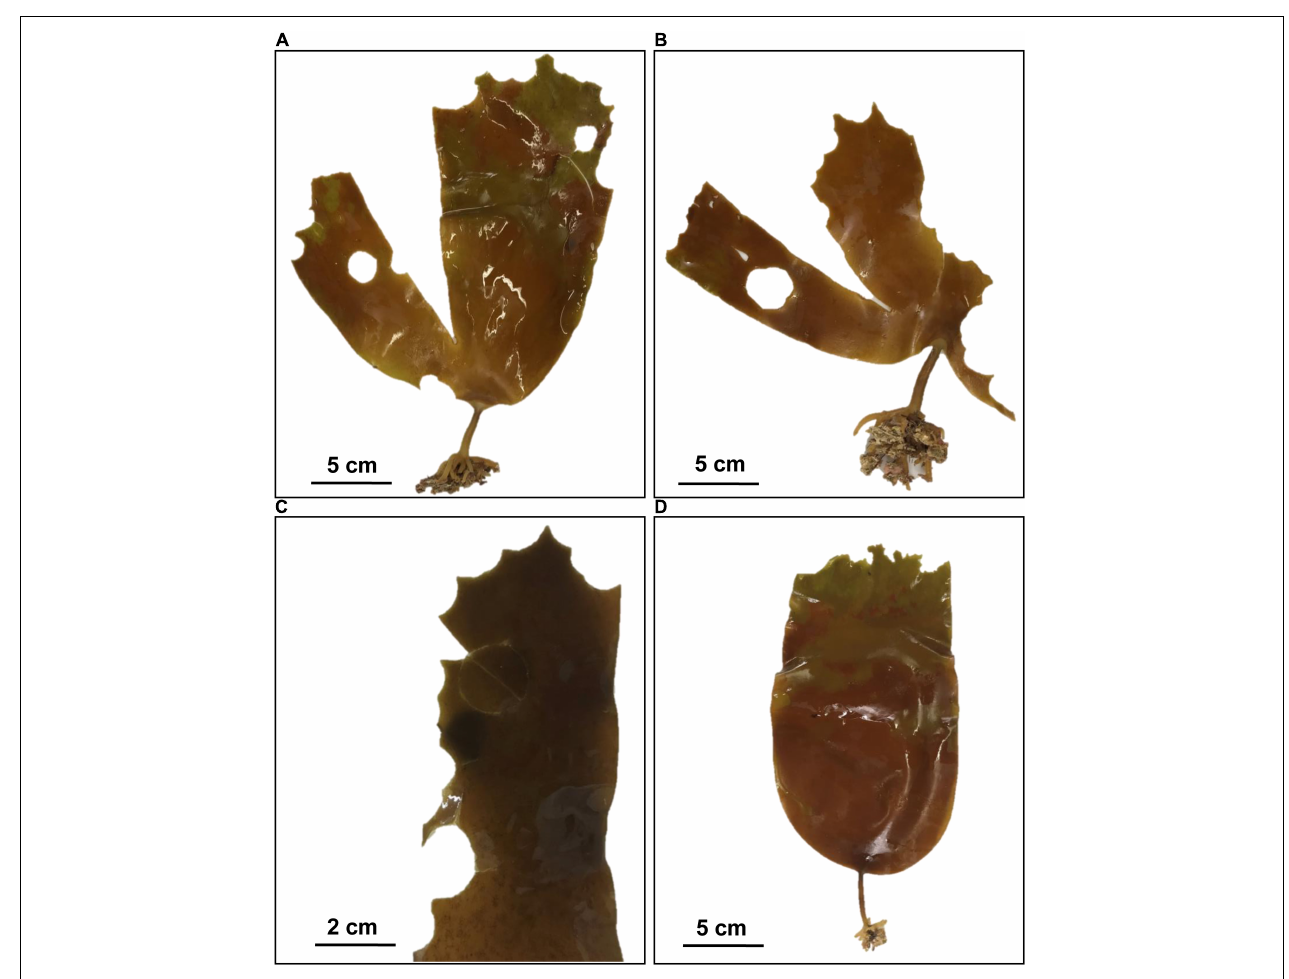
FIGURE 2 | Laminaria ochroleuca . Examples of (A–C) clear crescent and circular shaped fish bite marks and (D) irregular serrated sea urchin bite marks on golden